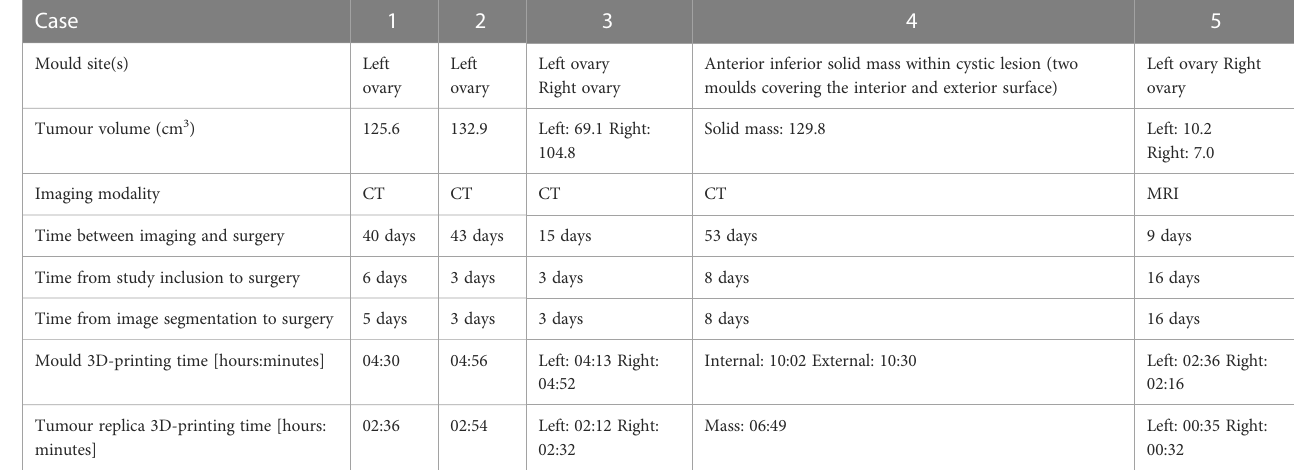
TABLE 2 Mould and pathway